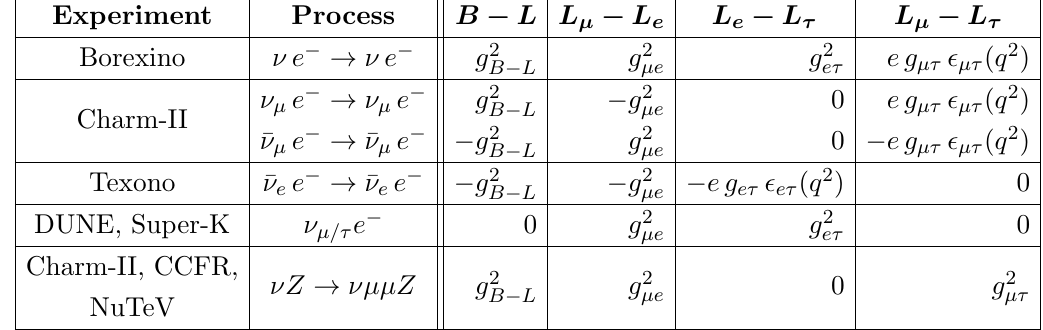
Table 4 . Coupling strengths for the di(cid:11)erent gauge groups relevant at neutrino experiments. Note that the hidden photon of a secluded U(1) X does not have any neutrino couplings and therefore is not constrained by these